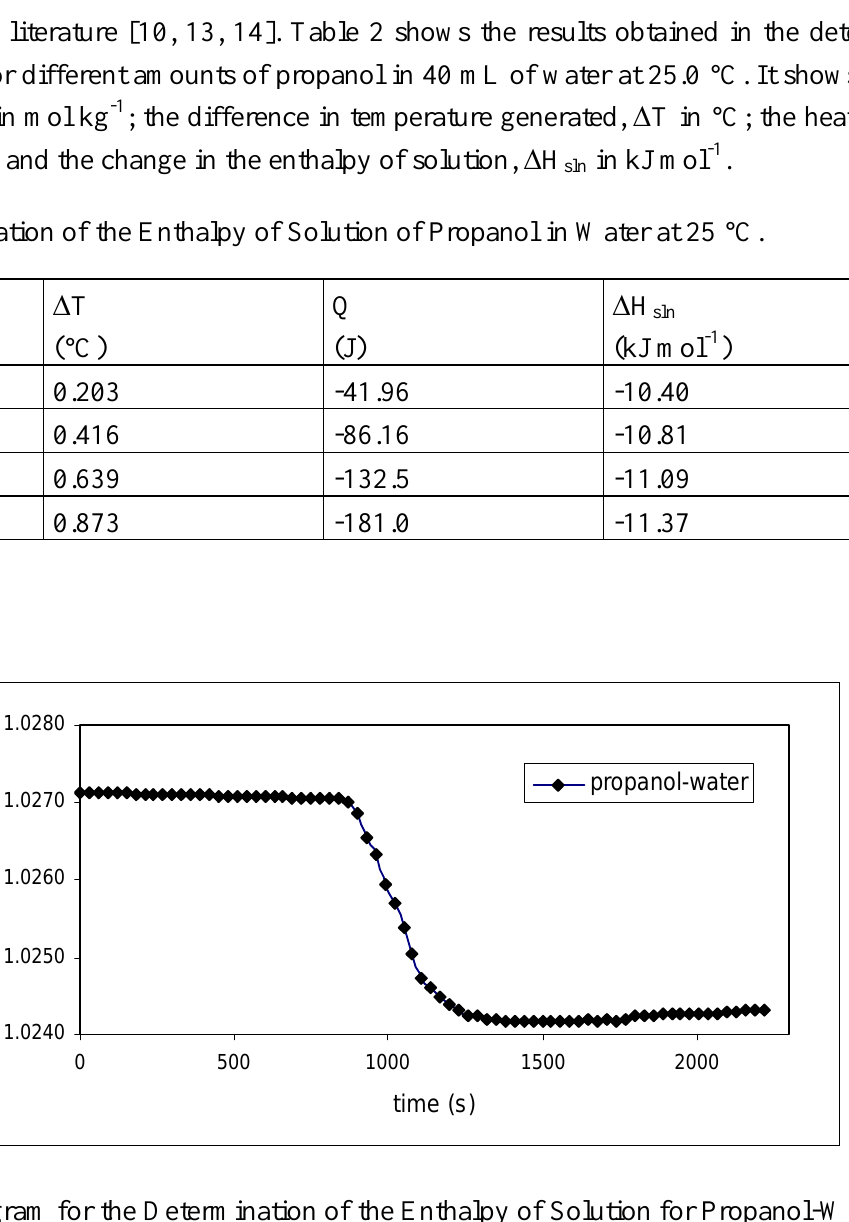
Figure 5. Thermogram for the Determination of the Enthalpy of Solution for Propanol-Water